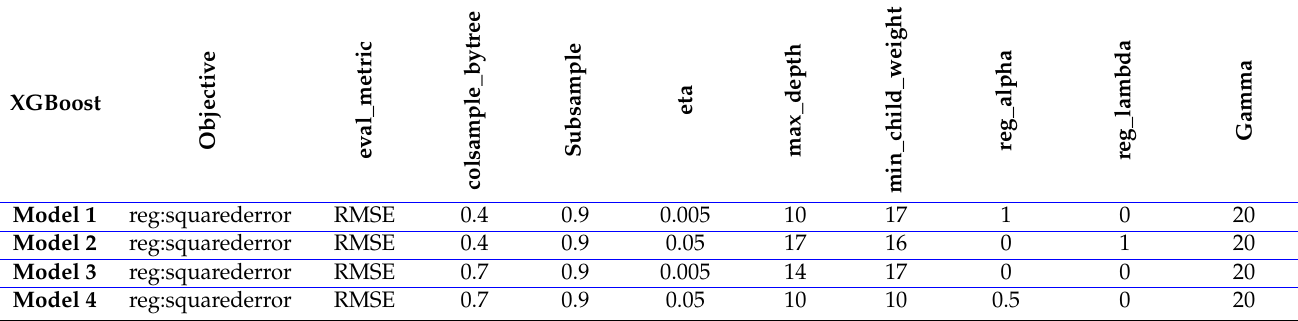
Table A6. Optimal hyperparameters for the XGBoost models (s-serie laser